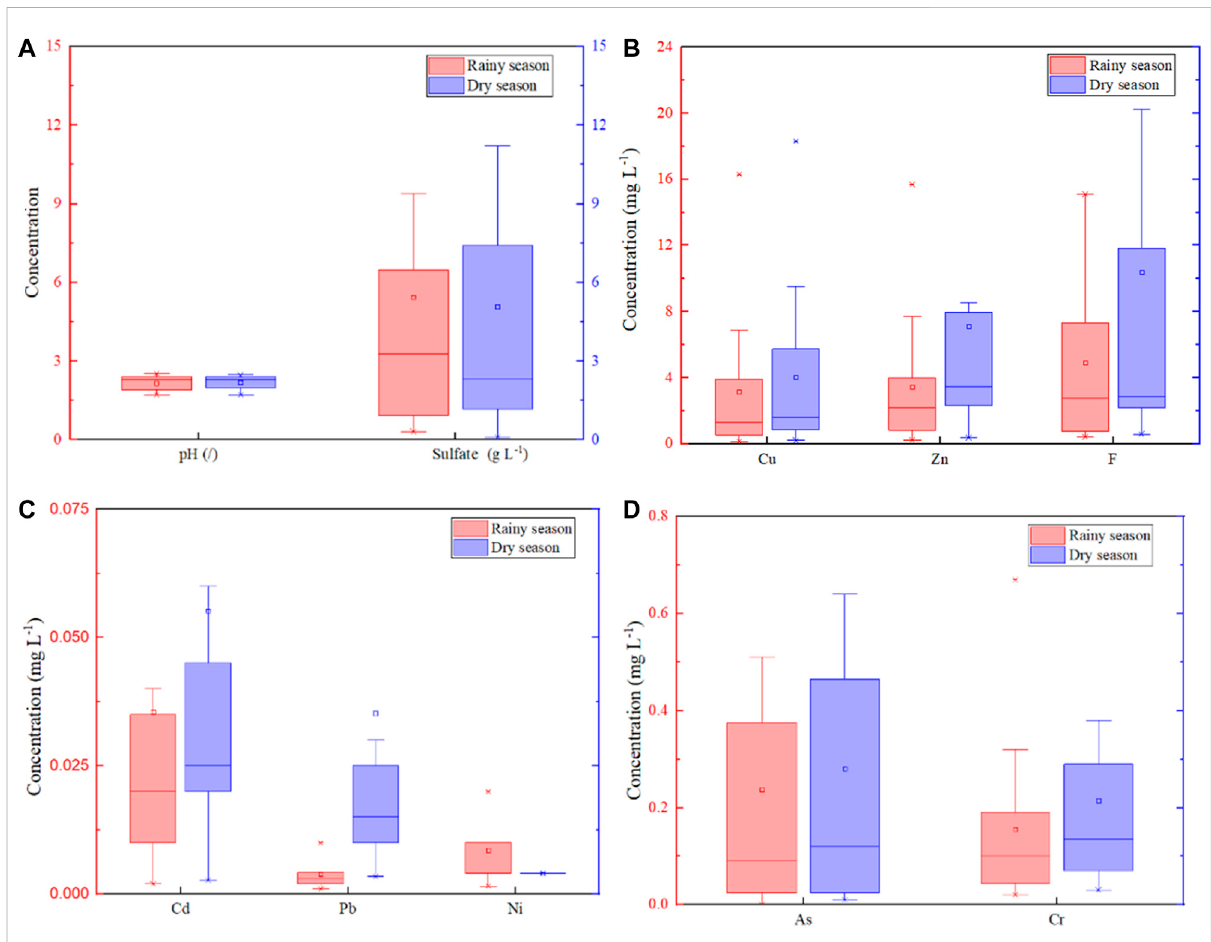
FIGURE 5 ComparisonofthepHvalueandtheconcentrationchangeofSulfate (A) ,Cu,Zn,andF (B) ,Cd,Pb,andNi (C) ,As,andCr (D) in24ARDsamplesin different